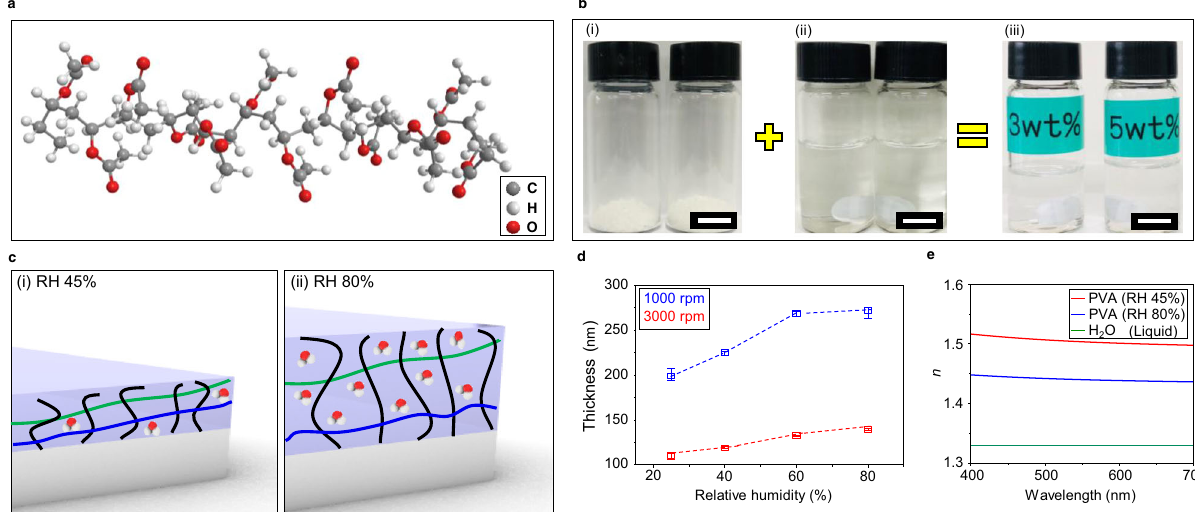
Fig. 1 | Characterization of the swelling and optical properties of polyvinyl alcohol thin fi lms. a Schematic of the molecular structure of polyvinyl alcohol (PVA). b AqueousPVAsolutionsarecreatedbydissolving(i)solidPVApowderinto (ii) deionized water with concentrations of (iii) 3 and 5wt%. All scale bars: 5mm. c SchematicillustrationoftheswellingmechanismofPVA.Astherelativehumidity (RH) increases from (i) RH 45 to (ii) 80% the amount of H 2 O molecules absorbed